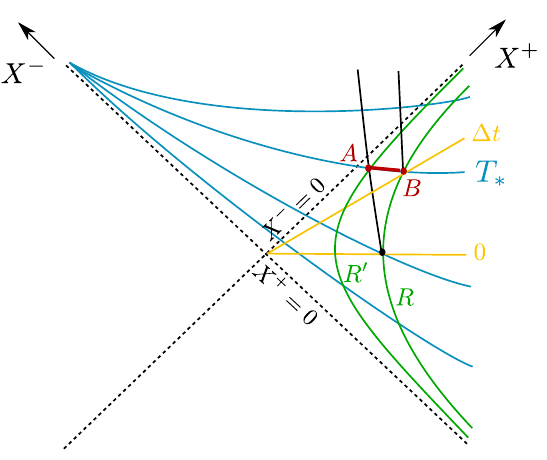
Figure 4 . The blue, yellow and green lines correspond, respectively, to slices of constant nice slice time T , Schwarzschild time t and radial coordinate r . The trajectories of the two D-branes are shown in black with the red segment representing the open strings stretched between the D-branes at (cid:12)xed nice slice time T (cid:3)